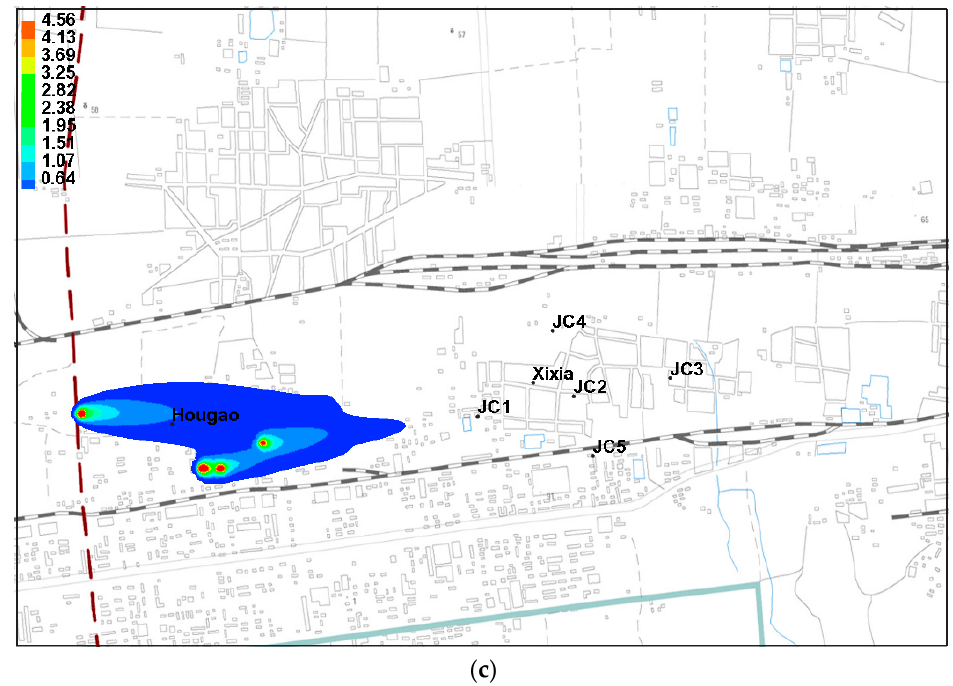
Figure 15. Prediction diagram of ammonia nitrogen transport under the combined action of Hougao strong pumping wells and hydraulic interception wells; ( a ) five years; ( b ) ten years; ( c ) twenty years . The concentration change curve is drawn according to the concentration monitoring data of the monitoring well, as shown in Figure 16. The peak concentration of the monitored well was only 0.11 mg/L. The pollutant concentrations in the Xixia area were all lower than the water standard limit of class Ⅲ , indicating that the pollutant concentrations were effectively controlled after the adoption of hydraulic interception wells.